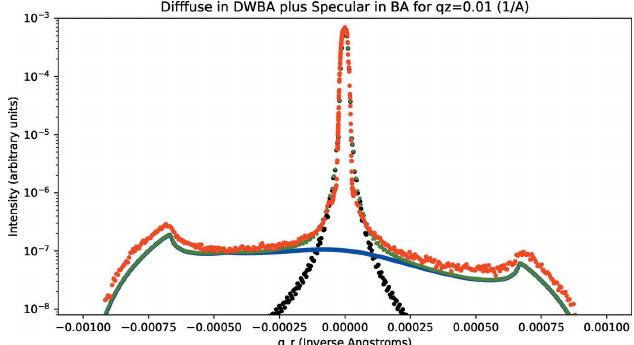
Figure 8 Smooth sample: rocking data and calculated fit (green) for q z = 0.10 A˚ (cid:2) 1 ; measured data (red), calculated specular scattering in the BA (black), calculated diffuse in the DWBA (blue), and total calculated scattering (green).